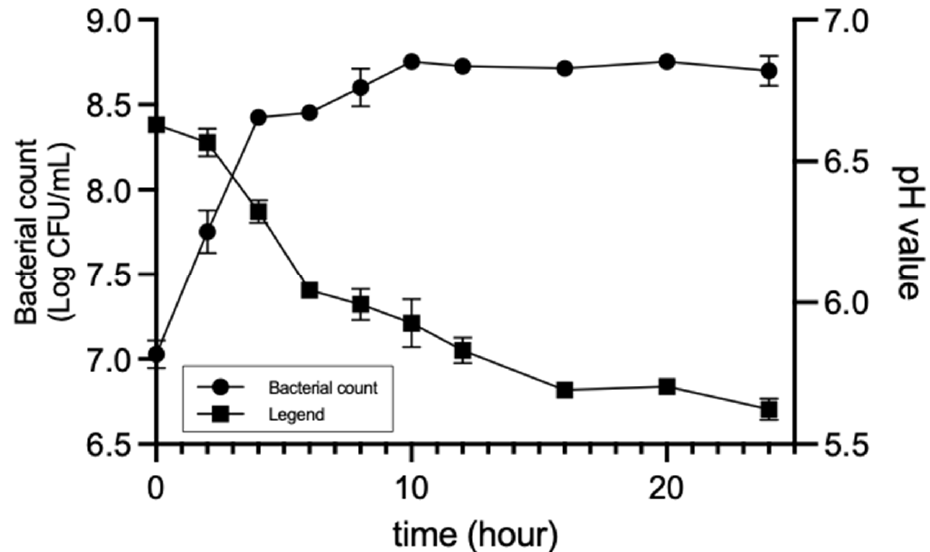
Figure 2. Growth curve of turmeric milk fermented by L. brevis BCRC12247. Values are the mean ± SD.